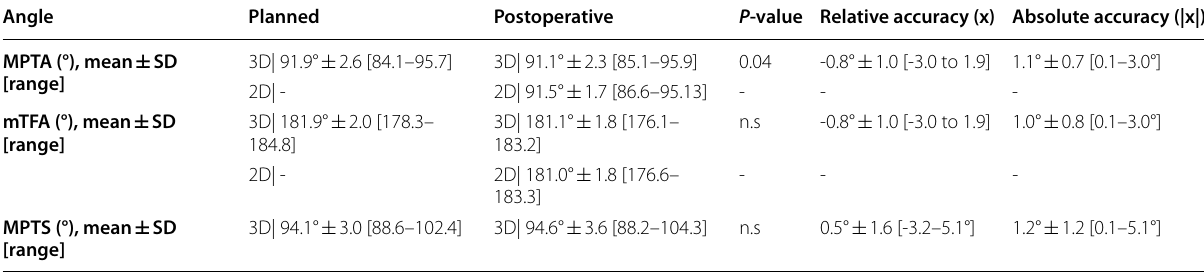
Table 2 The planned, postoperative and accuracy outcomes in 3D and 2D. (MPTA, medial proximal tibial angle mTFA, mechanical tibiofemoral angle; MPTS, medial posterior tibial slope) Angle Planned